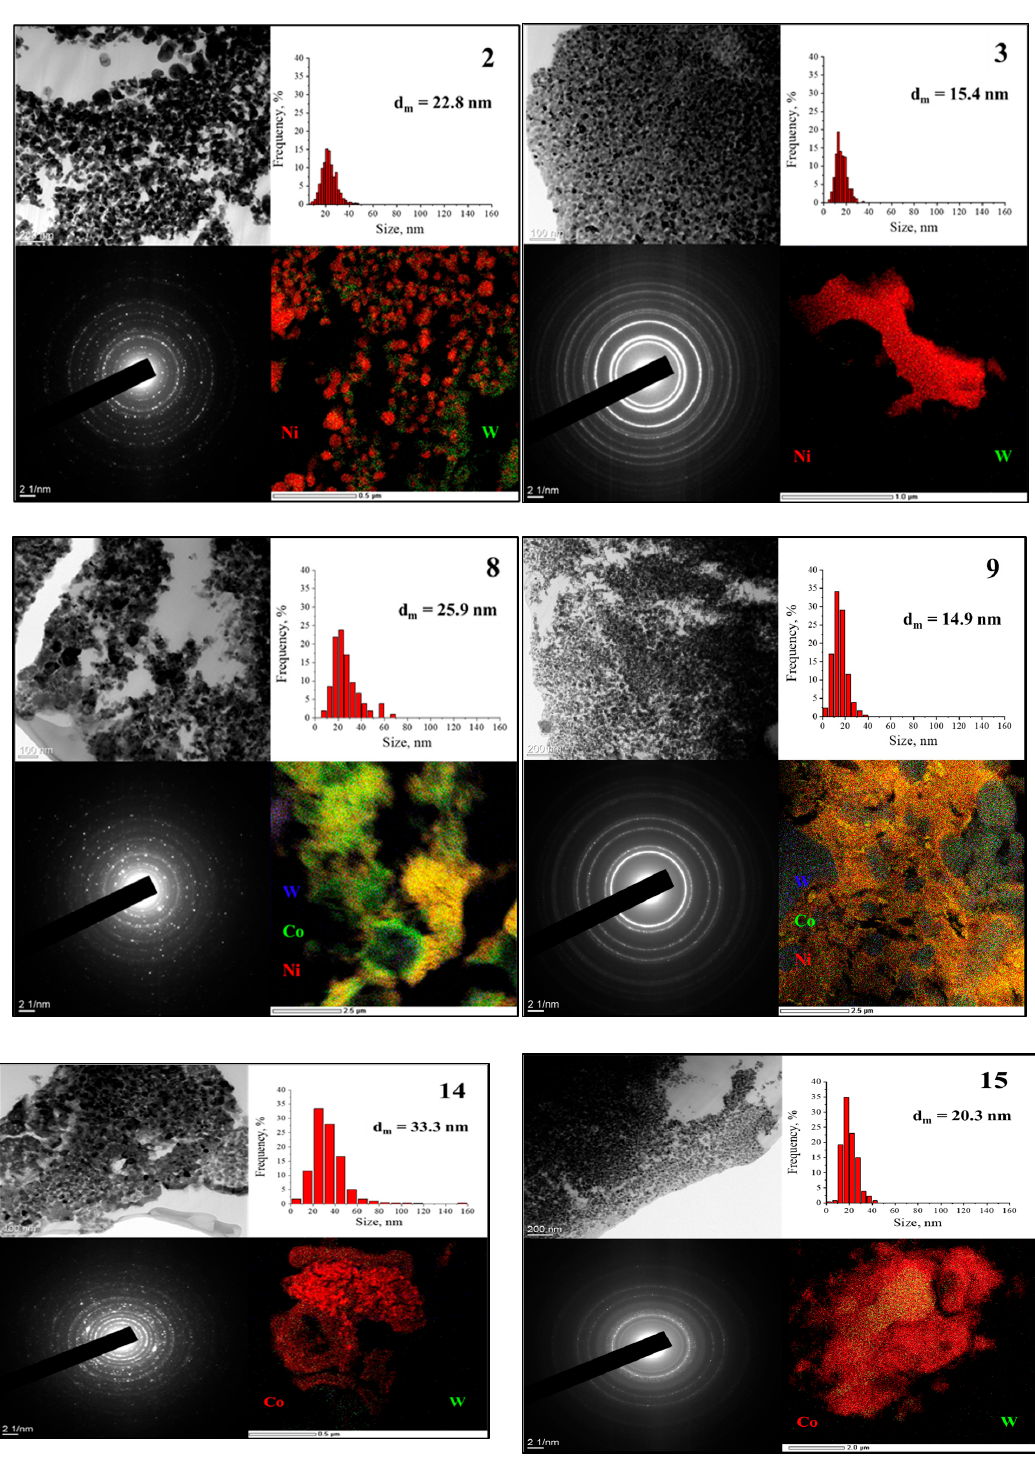
Figure 1. TEM images, particle distribution histograms, selected area electron diffraction (SAED) patterns and EDX elemental mapping of: ( 2 )—20%Ni/WC_IWI; ( 3 )—20%Ni/WC_DP; ( 8 )—10%Ni_10%Co/WC_IWI; ( 9 )—10%Ni_10%Co/WC_DP; ( 14 )—20%Co/WC_IWI; ( 15